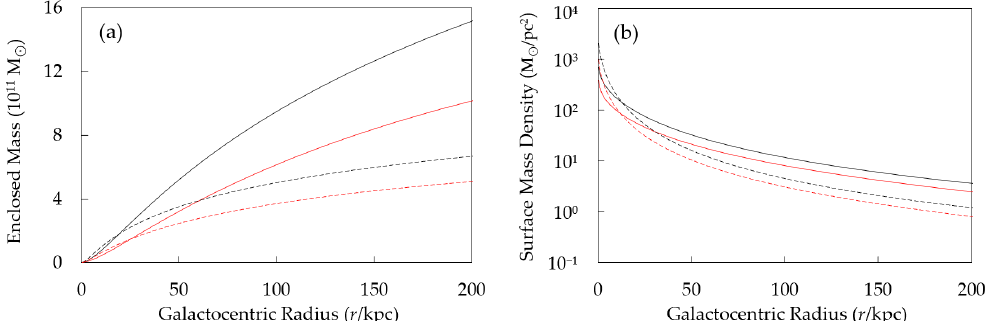
Figure 2. ( a ) Black dashed curve replicates Geehan 2006 [32] “best-fitting model” dark halo mass for M31 galaxy, enclosed in a cylinder 3 of radius r ; red dashed curve is the corresponding DM2 disk mass fitting Geehan halo RC. The Black solid curve is Sofue 2015 [34] dark halo model mass enclosed in a cylinder ( < r ); the red solid curve is the corresponding mass of DM2 disk. ( b ) The Black dashed curve is Geehan 2006 halo surface mass density; the red dashed curve is the corresponding DM2 disk density. The Black solid curve is Sofue 2015 halo surface mass density; the red solid curve is the corresponding DM2 disk